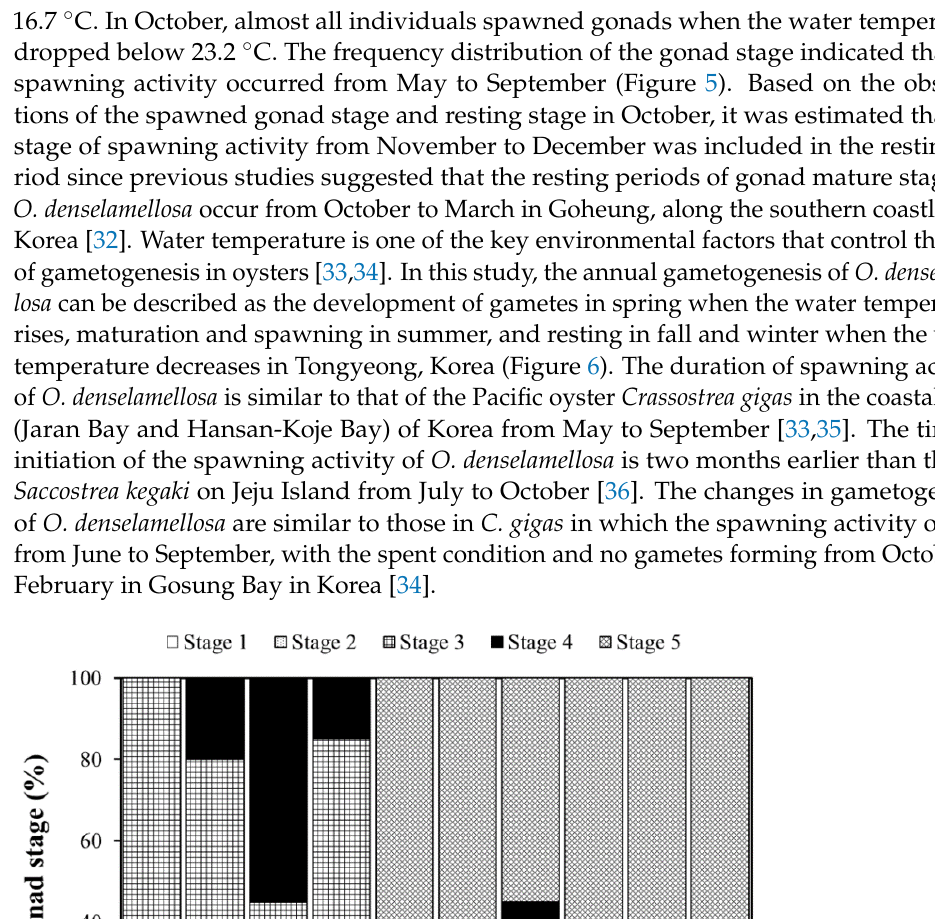
9 of 12 Figure 4. Photomicrographs of histological sections of Ostrea denselamellosa during gametogenesis. ( A ) Resting stage. ( B ) Early gametogenesis stage. ( C ) Advanced gametogenesis stage. ( D – F ) Mature gonad stage of males, females, and hermaphrodites. ( G ) Spawned gonad stage. EVO, early